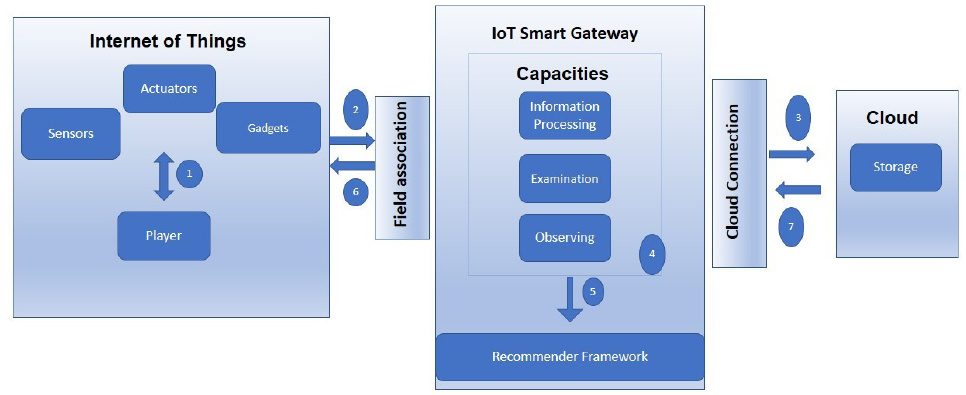
Figure 1. IoT Architecture.